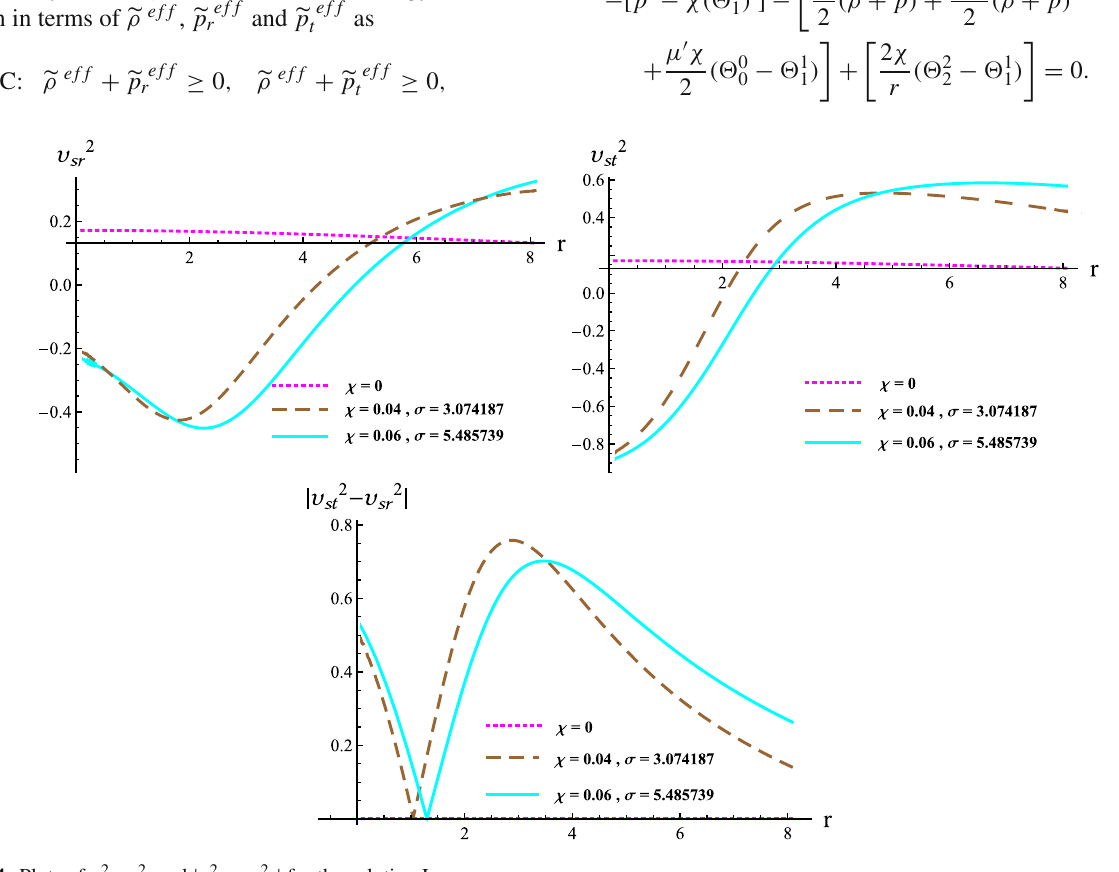
Fig. 4 Plots of v 2 sr , v 2 st and | v 2 st − v 2 sr | for the solution